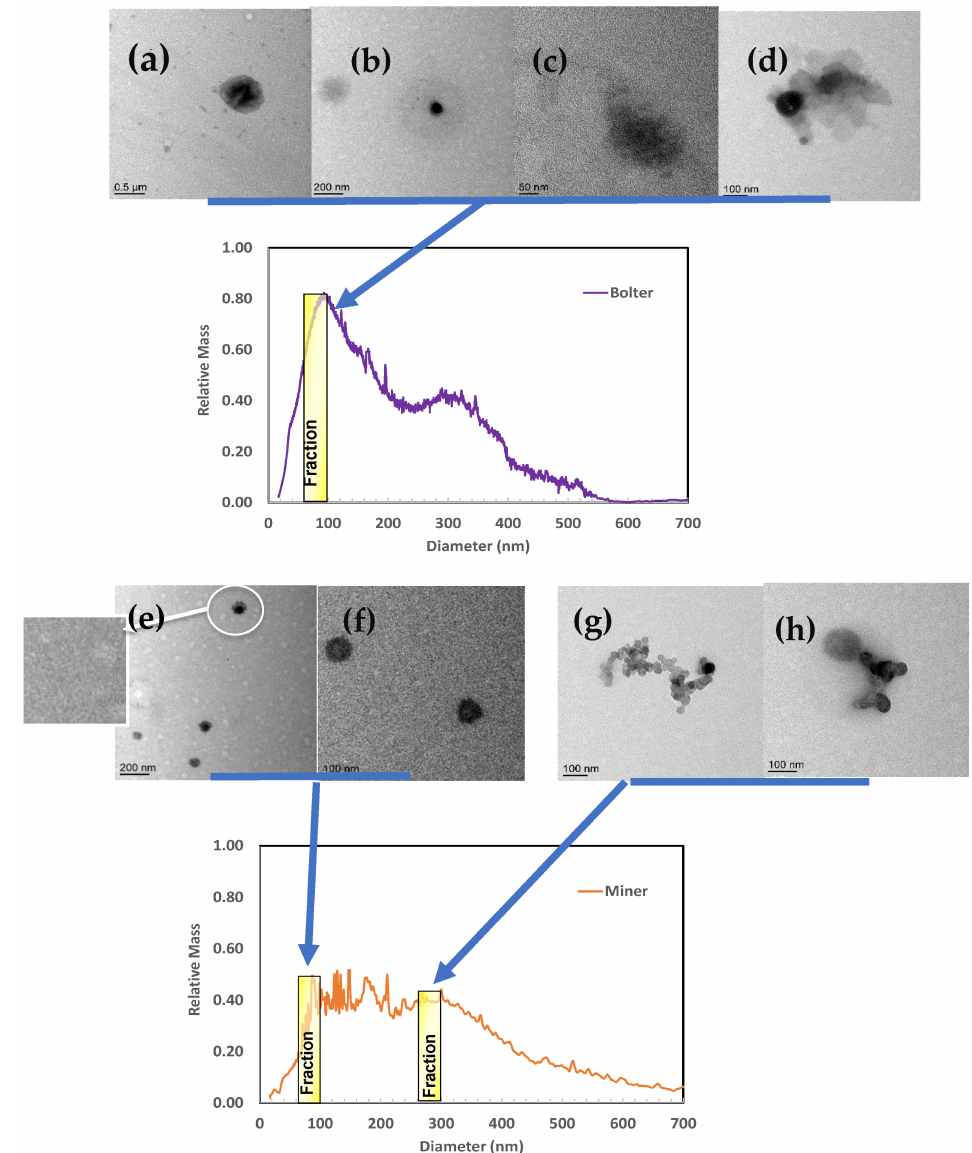
Figure 5. TEM images of the isolated RCMD nanoparticles from the bolter and the miner samples showing carbonaceous ( a – f ) aggregate of aluminosilicate particles ( d ), soot aggregate ( g )and aggre- gate of carbonaceous particles ( h ). The yellow bar on the size distribution graphs shows the location of the fraction